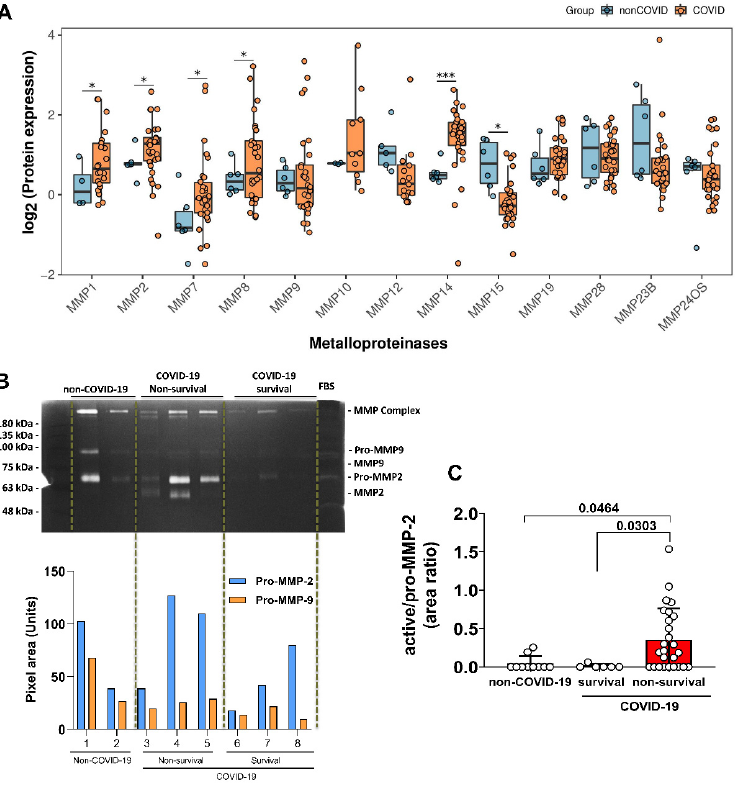
Figure 1. The expression of matrix metalloproteinase and active-MMP-2 form increased in COVID-19 lung. ( A ) Protein expression data obtained from literature [37] was reanalyzed aiming to evaluate MMPs expression changes. Significant changes are indicated by nominal p -values ( * p < 0.05 and *** p < 0.001). Only MMP-14 presented significant difference with adjusted p -value equal to 0.000508. ( B ) Expression and different molecular weight forms of MMP-2, cleavage of pro-MMP-2 to active MMP-2, and MMP-9 analyzed by gelatin zymography. Representative gel from non-COVID-19 ( n = 13), survival ( n = 6) and non-survival ( n = 33) COVID-19 patients is shown. Positions of pro-MMP-9, pro-MMP-2 and active MMP-2 with sizes in kDa are indicated. ( C ) Quantification of active-MMP-2 represented by area ratio to pro-MMP-2. Statistical analyzes were performed using the Kruskal-Wallis multiple comparison test, followed by the Dunns post-test to compare pairs. Data are expressed as median with 95% confidence intervals. Statistical differences between groups are considered by p < 0.05 and represented directly in the graphic figure.